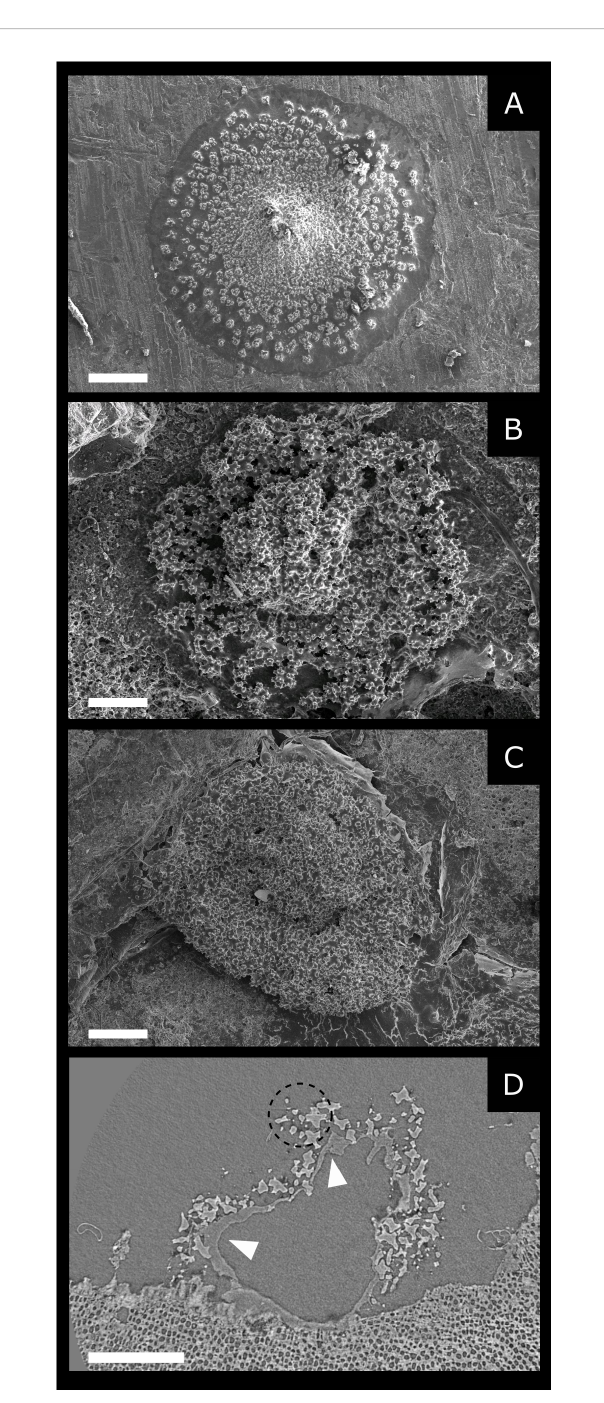
FIGURE 3 (A – C) Scanning electron microscopy: SE mode. Recruits at different ages: